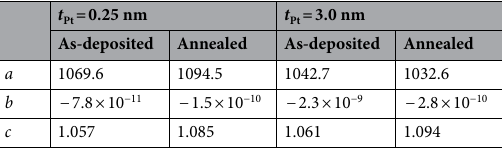
Table 1. Summary for the parameters of the equation; y = a ( x − b ) c .